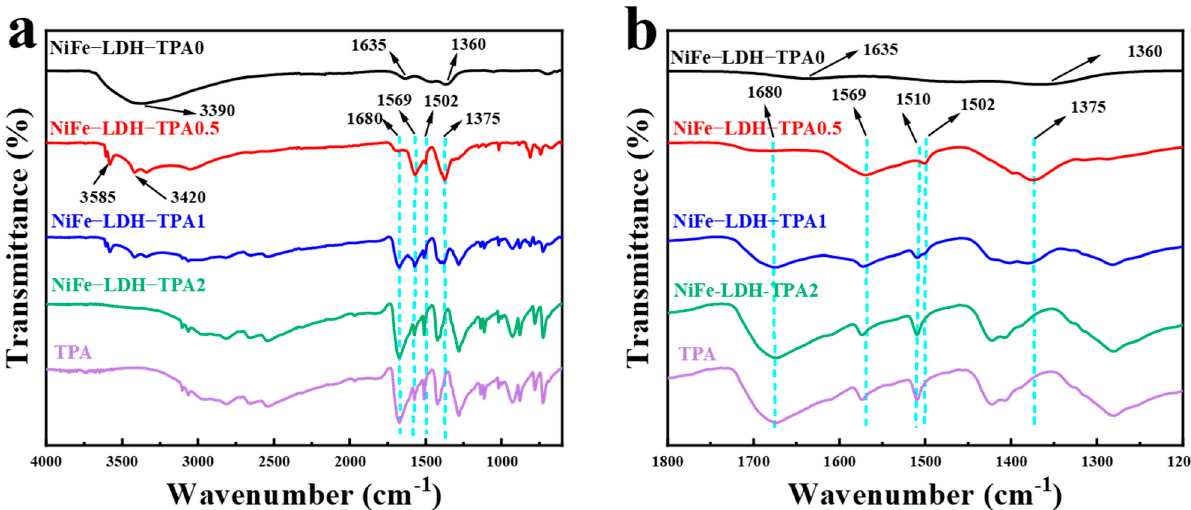
Figure 4. Fourier transform infrared (FTIR) spectra. ( a ) FTIR spectra of NiFe-LDH-TPA0, NiFe-LDH- TPA0.5, NiFe-LDH-TPA1, NiFe-LDH-TPA2 powder, and TPA as a reference. ( b ) Zoom in ( a ) on the